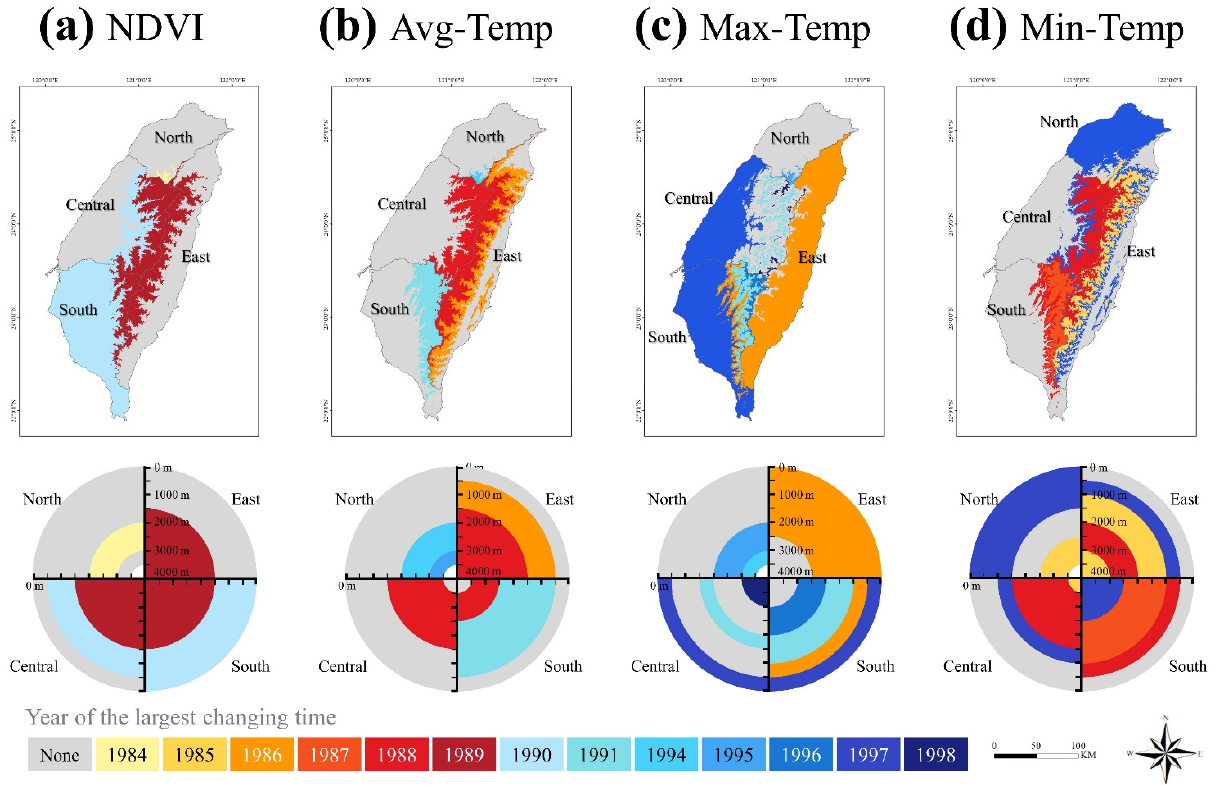
Figure 7. BFAST detected the largest change in time for the ( a ) NDVI, ( b ) average temperature, ( c ) maximum temperature, and ( d ) minimum temperature datasets.